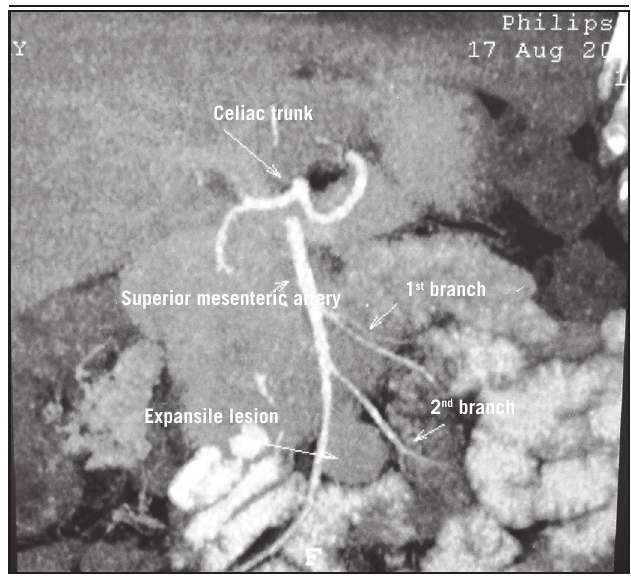
figurE 1 − CT: expansile lesion in the mesentery CT: computed tomography.